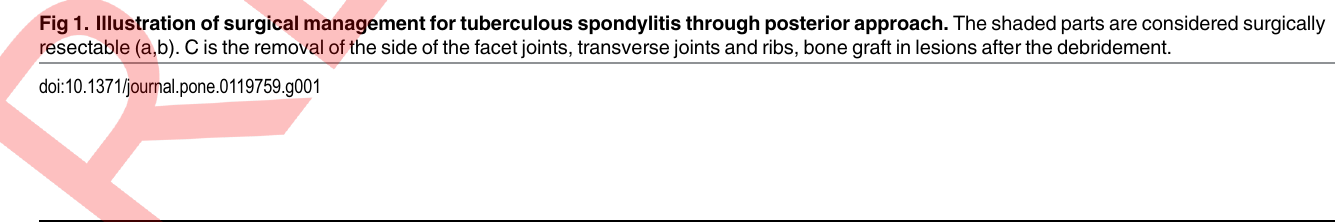
PLOS ONE | DOI:10.1371/journal.pone.0119759 March 17,